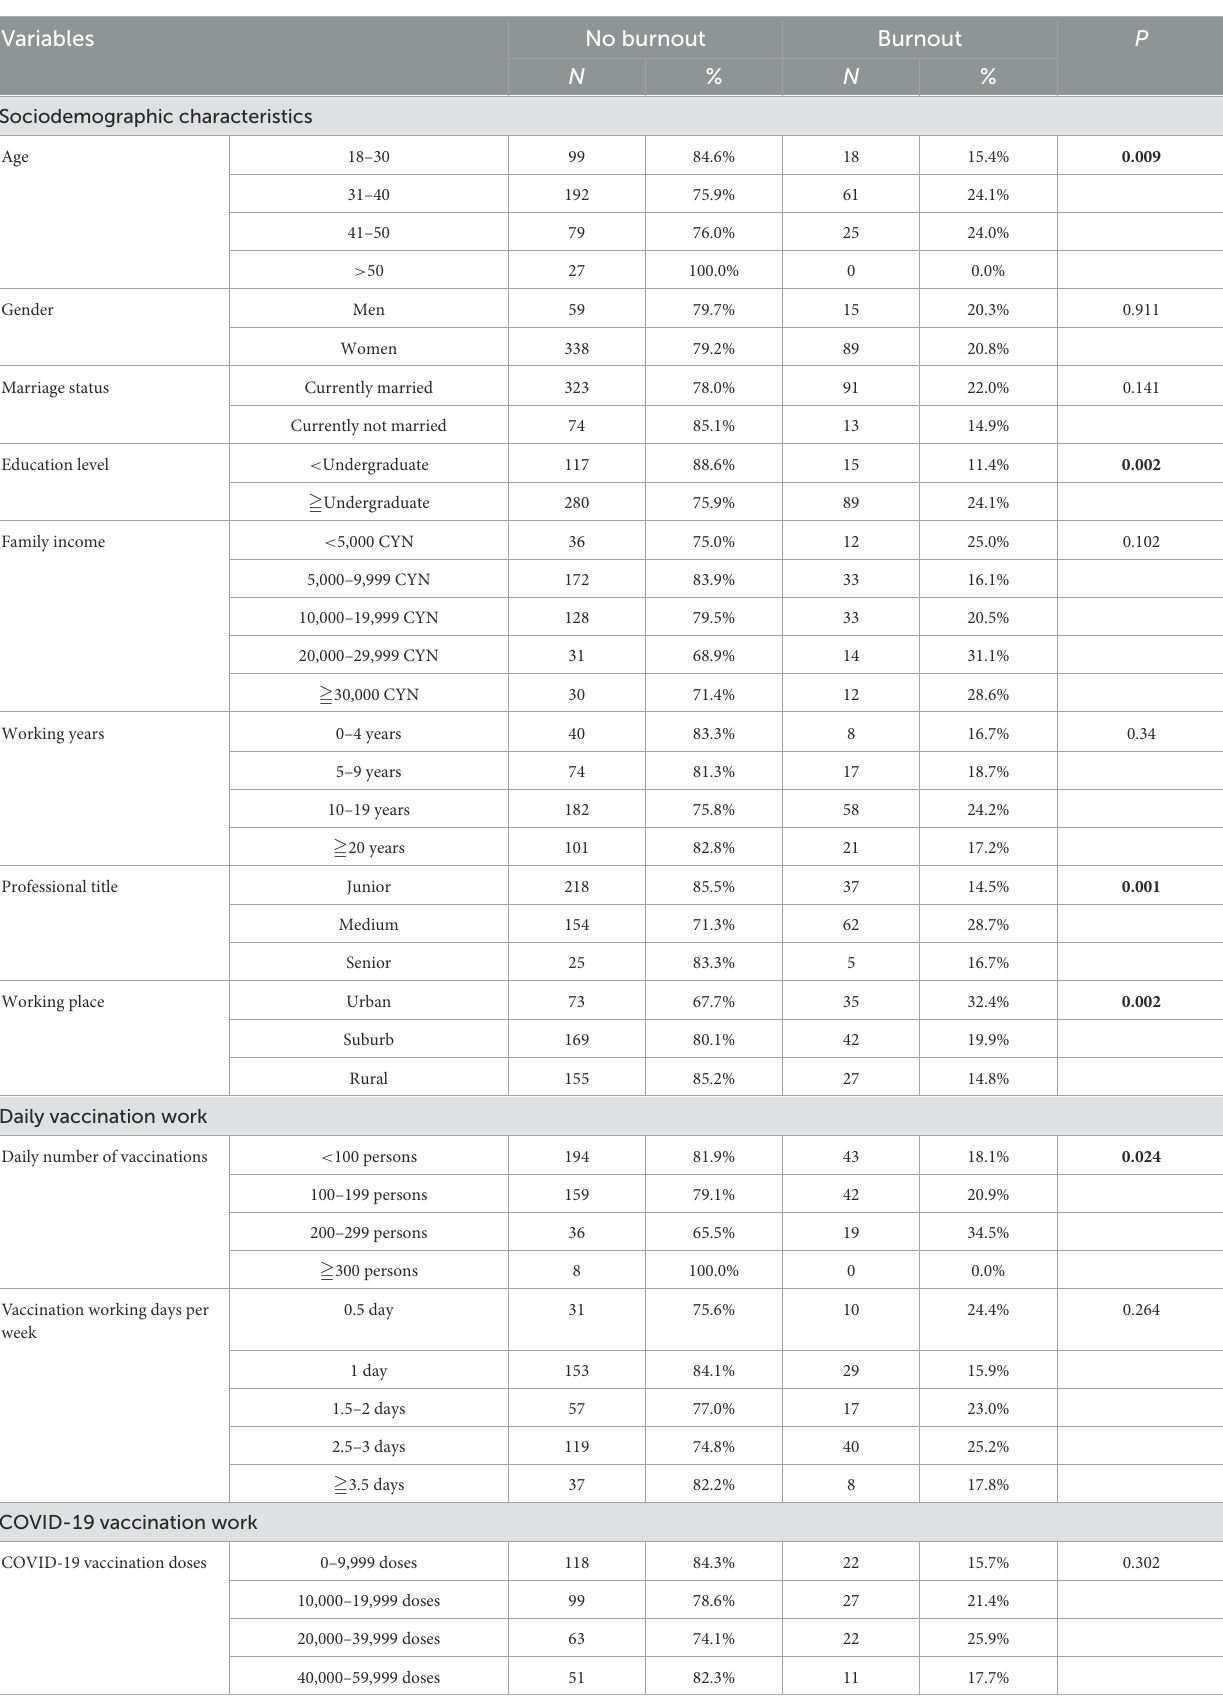
TABLE 2 Univariate analysis of the associated factors of burnout among vaccination staff. Variables No